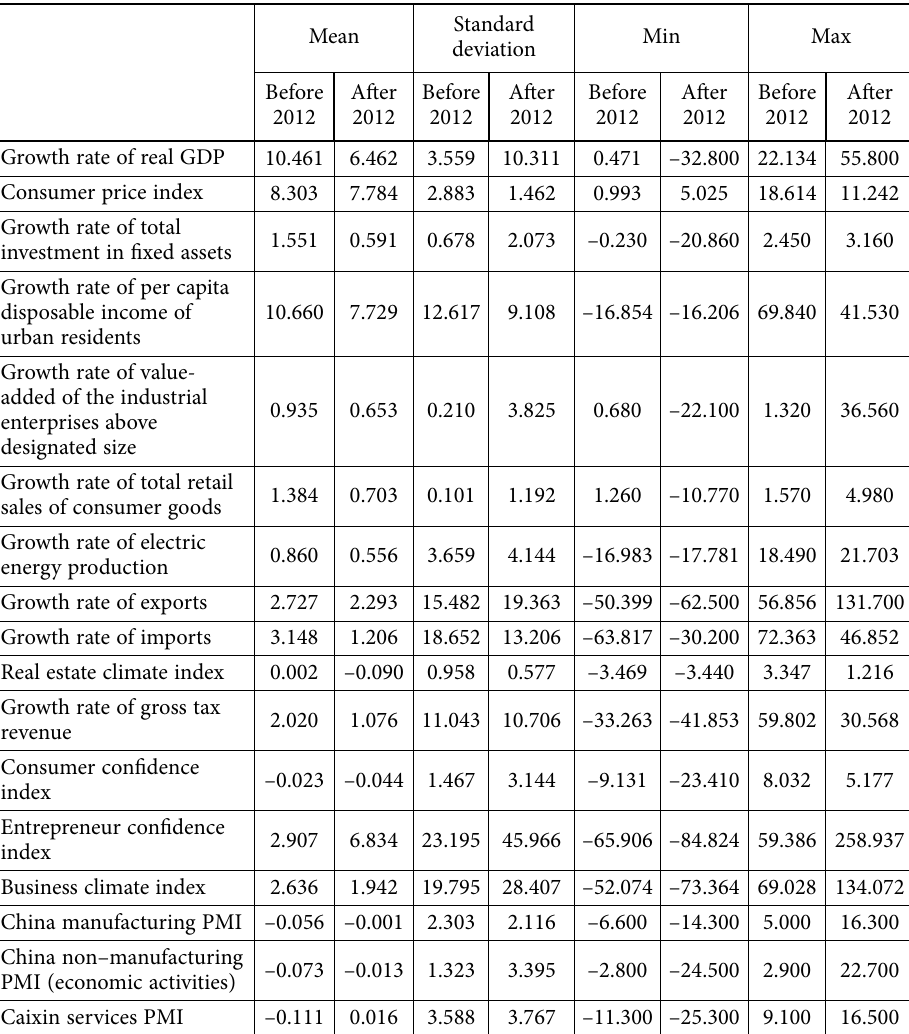
Table D1. Descriptive statistics of fundamental